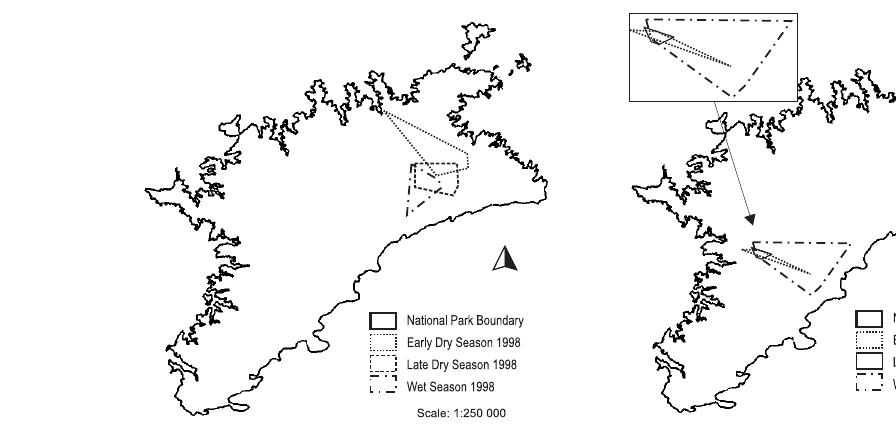
Fig. 7. Map of MNP indicating seasonal ranges of a wild female rhino number 21.